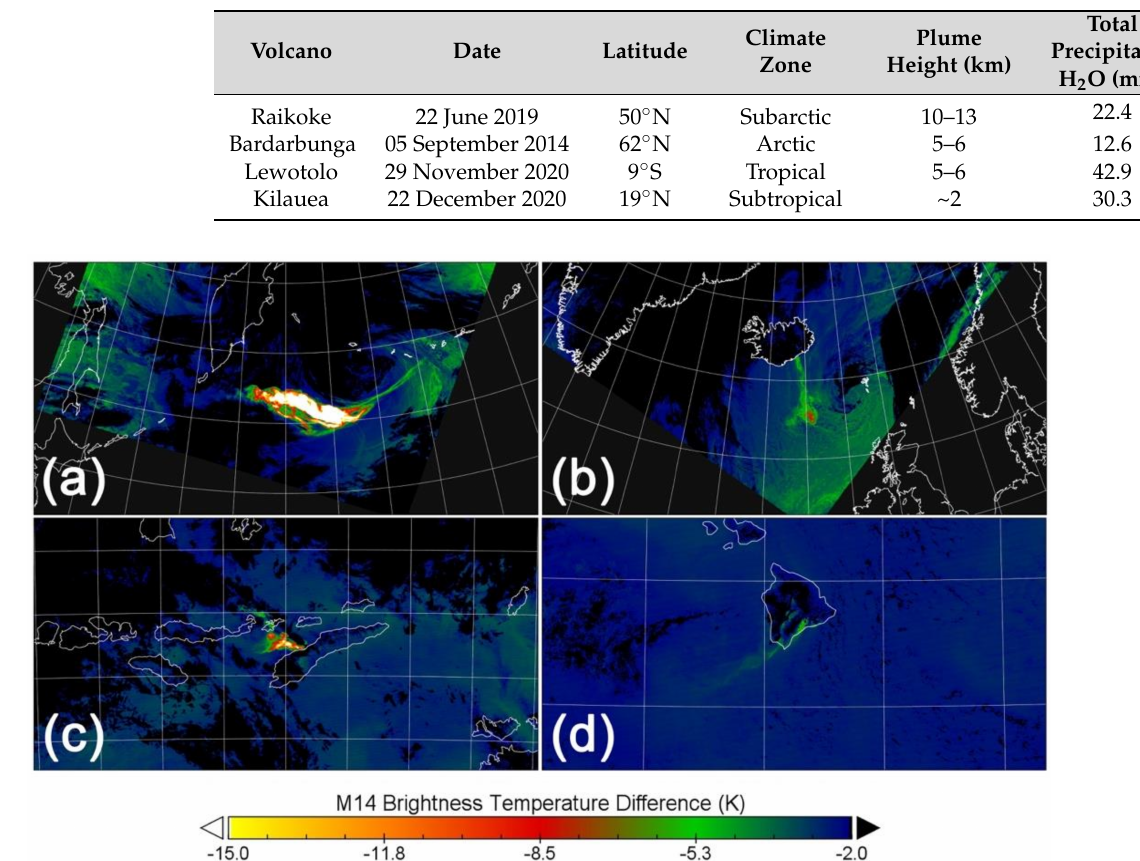
Figure 4. We evaluated the scaling of BTD14—(BT14 MAX(BT14, BT15, BT16)) through analysis of VIIRS observations of SO 2 plumes representing a range of plume heights and atmospheric conditions (Table 1). The SO 2 plumes were detected successfully in each test case: ( a ) Raikoke, ( b ) Bardarbunga, ( c ) Lewotolo, and ( d )